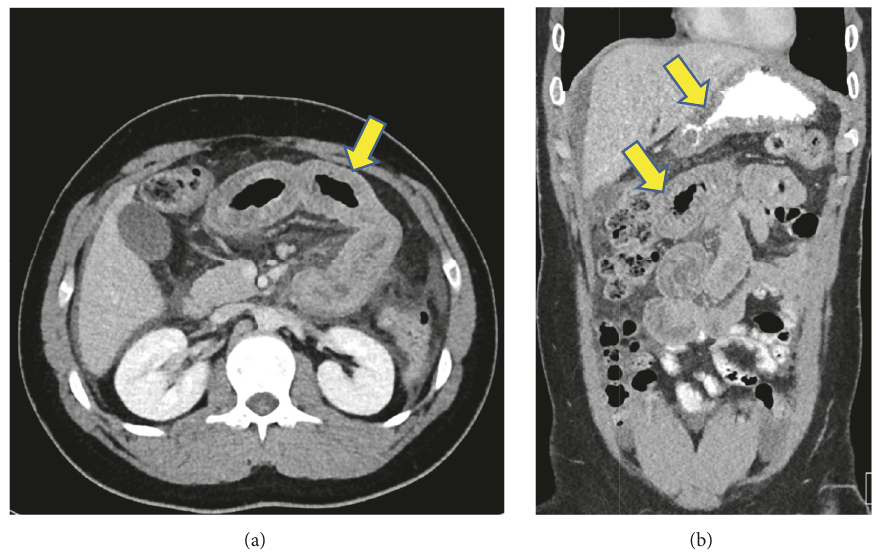
Figure1:AbdominalCTscanduringanacuteattackshowinglongsegmentsofenhancingmucosalthickeninginvolvingtheproximaljejunum (arrows in a and b) and gastric mucosa (upper arrow in b).